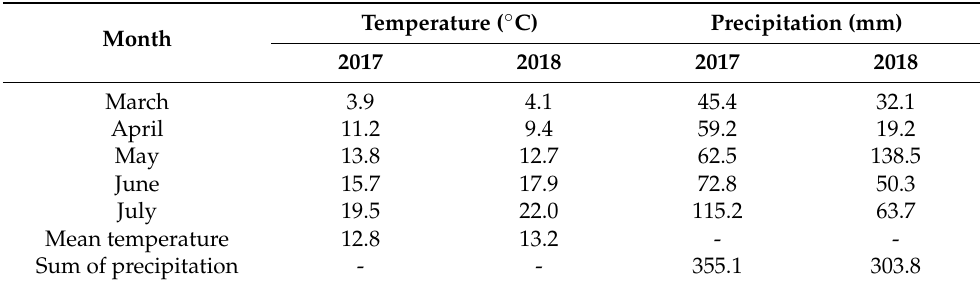
Table 1. Meteorological data for seasons of experiments (mean value).